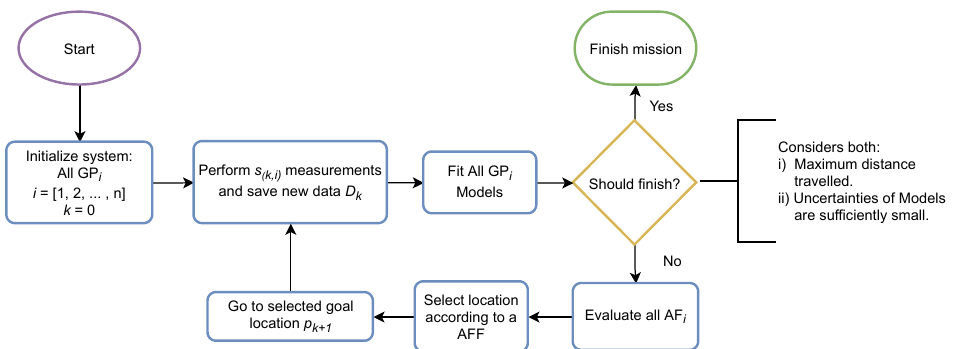
Figure 4. Proposed multi-function estimation using Bayesian optimization approach for environmen- tal monitoring using an